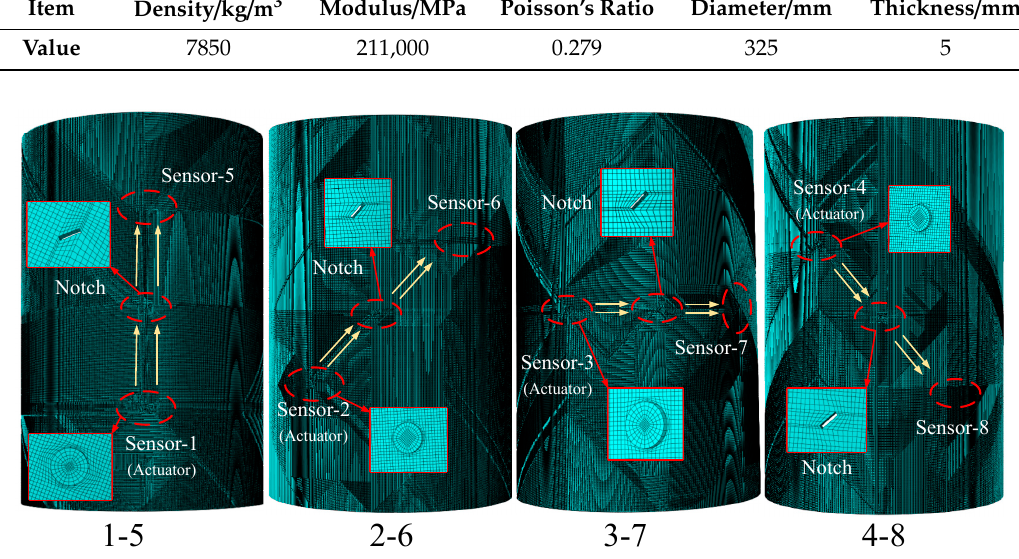
Figure 6. Finite element model of curved plates.